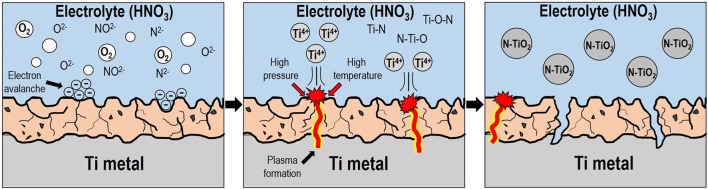
Schematic diagram of the N-TiO2 nanoparticle synthetic mechanism via plasma enhanced electrolysis.